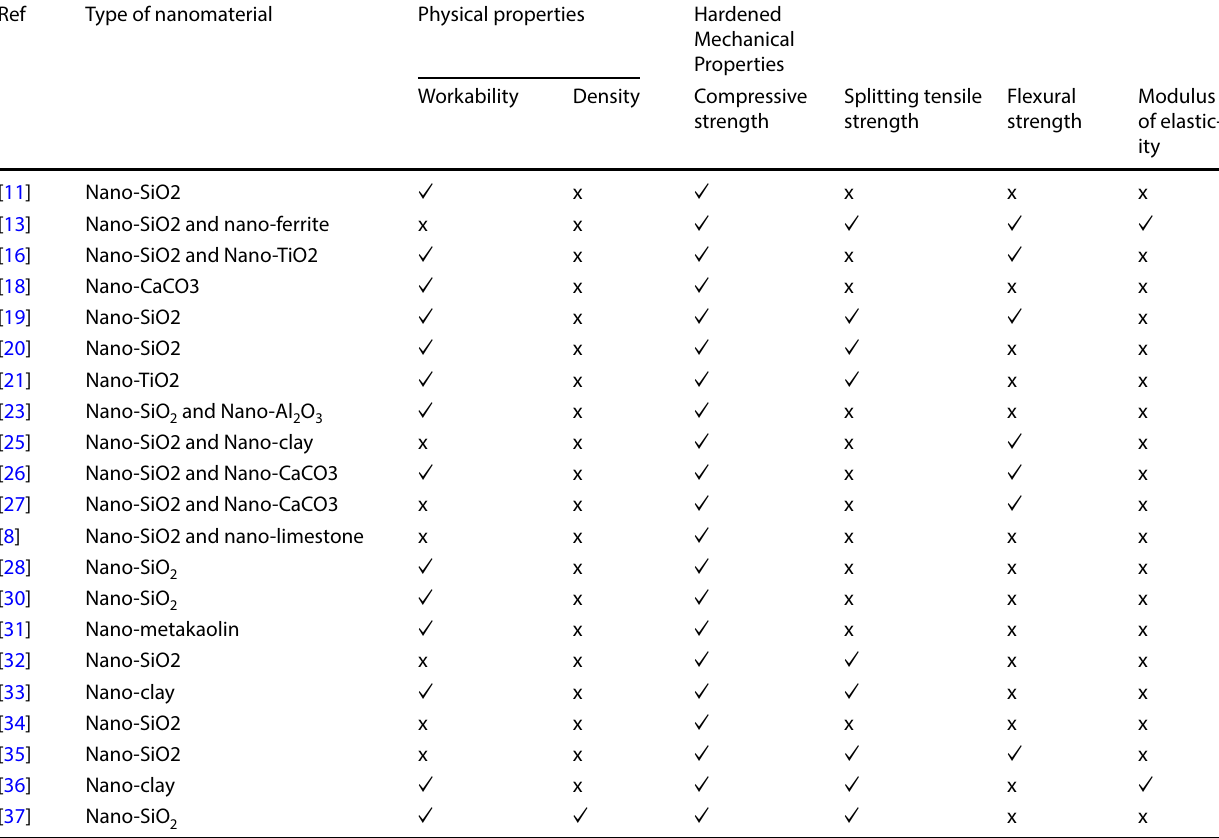
Table 2 Properties of nanomaterials used in previous studies Ref Type of